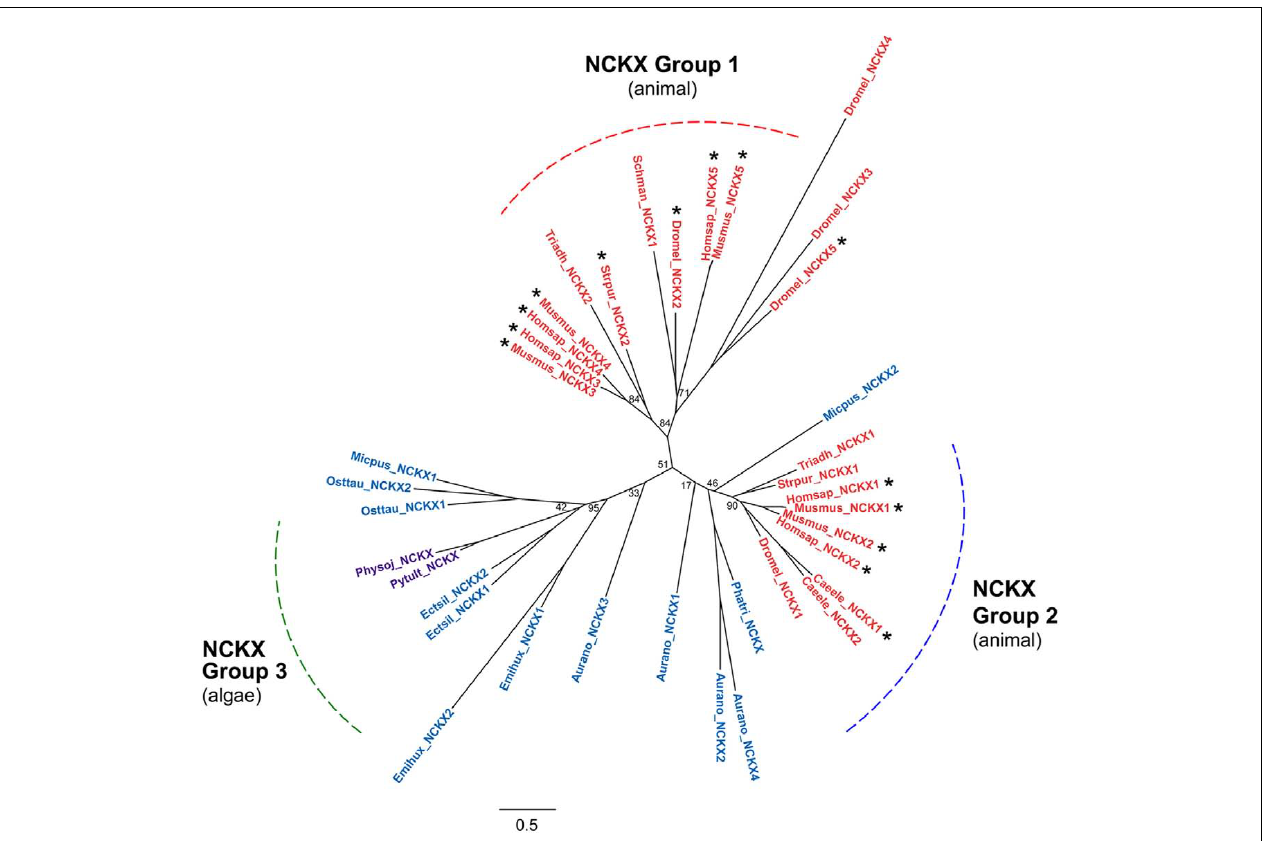
Figure 3 . Bootstrap values are indicated at the nodes of major branches. The branch length scale bar indicates the evolutionary distance of 0.5 amino acid substitutions per site. Genes that are highlighted with an asterisk encode transporters for which the ion specificity has been